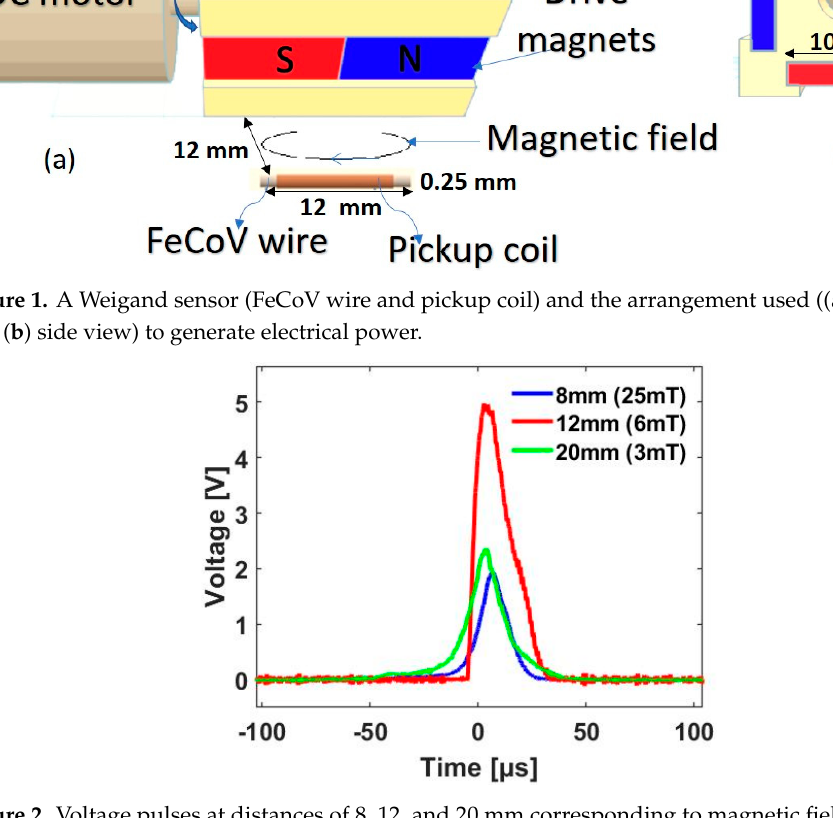
Figure 3. Energy consumption in the load resistor R L from a single Wiegand voltage pulse and corresponding voltage drop.